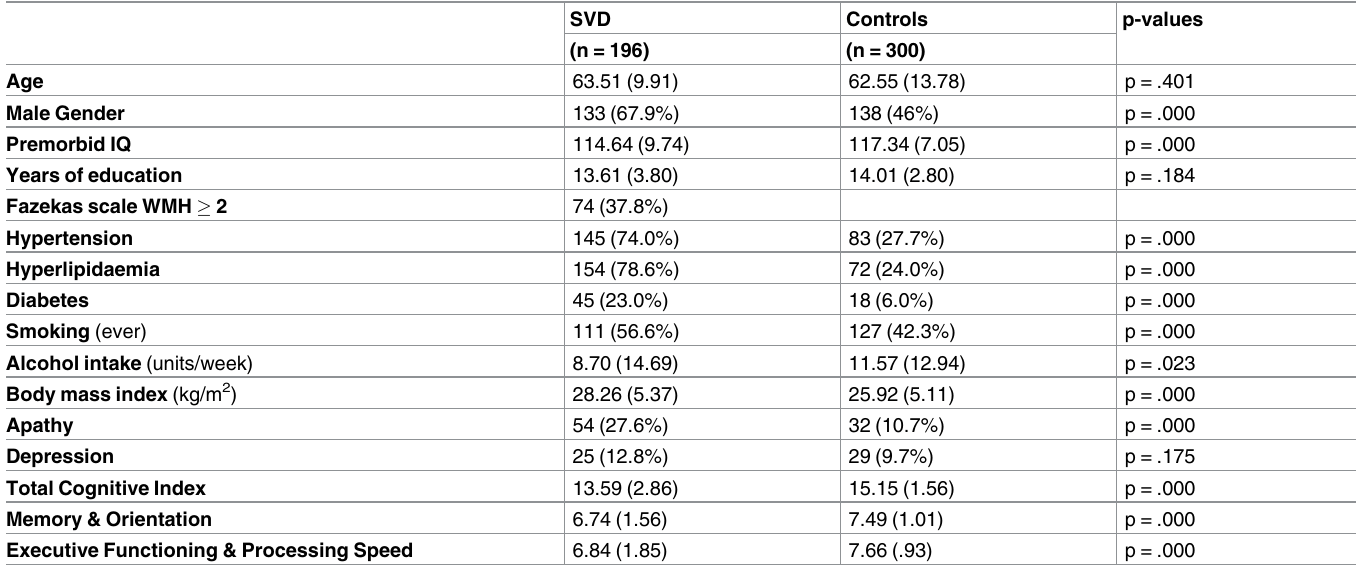
Table 1. Demographic and clinical variables for participants with SVD and